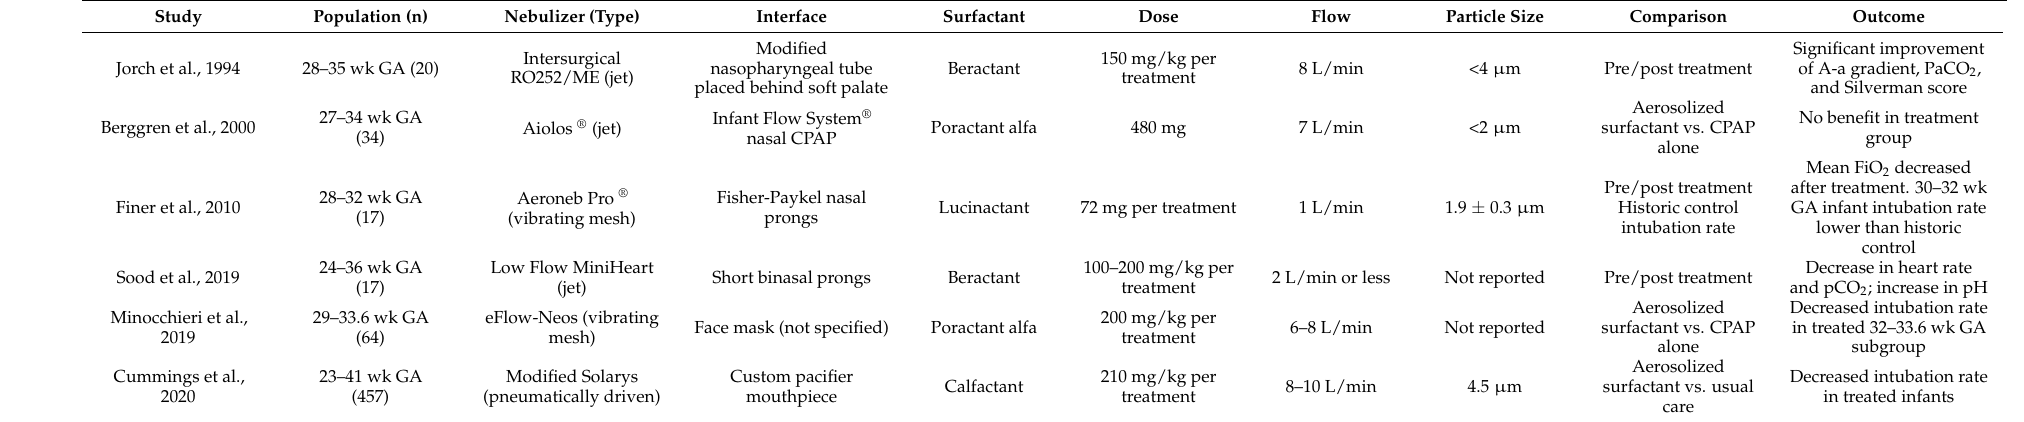
Table 1. Summary of aerosolized surfactants and nebulizers utilized in clinical studies in preterm